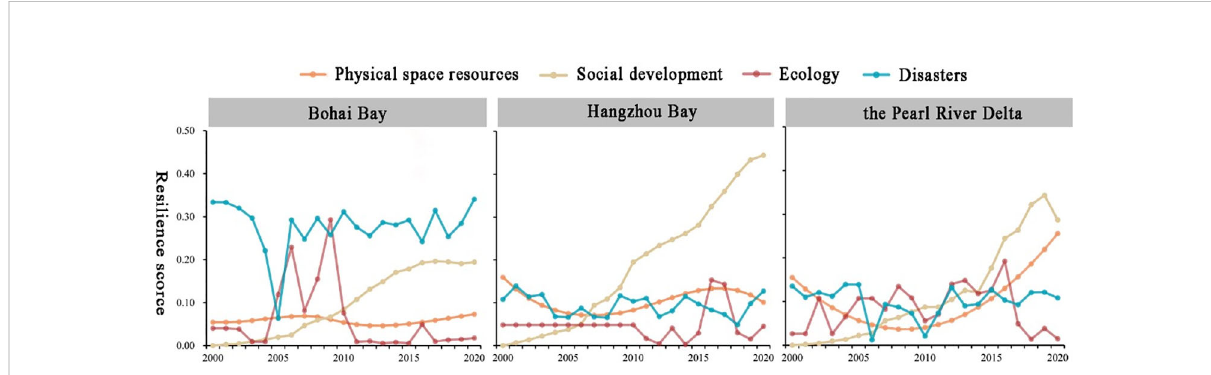
FIGURE 4 Line chart of resilience value for bays from 2000 to 2020. Different color indicates the four sub-resilience systems within the resilient system of bays. The ecological sub-resilience system has maintained a low level in the three bay areas, while the social development sub-resilience system has maintained an upward